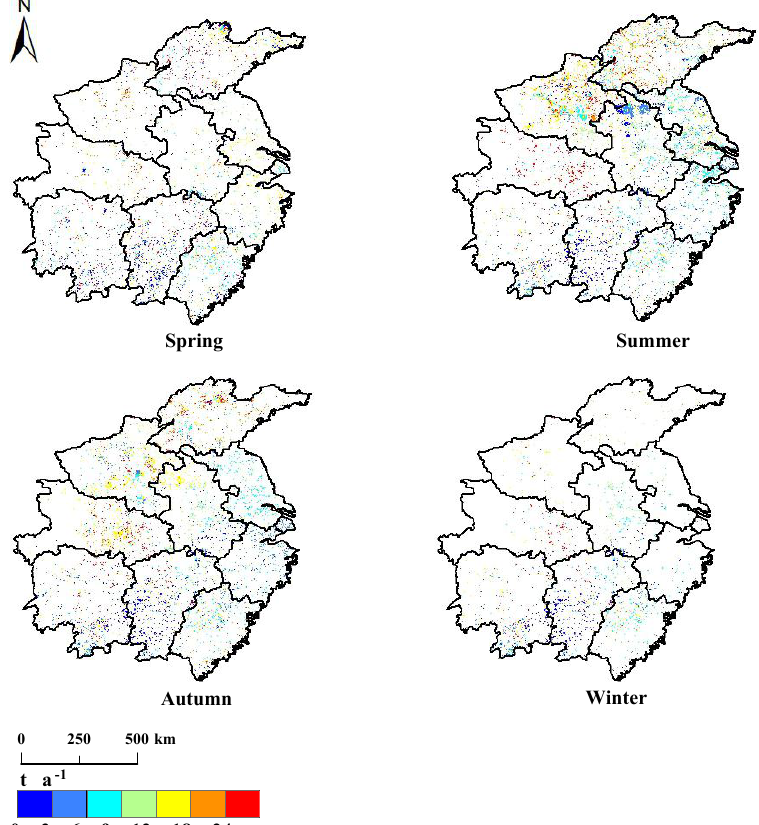
Figure 11. Seasonal emissions distribution (1km × 1km) of PM 2 . 5 in 2015 from opening biomass burning in central and eastern